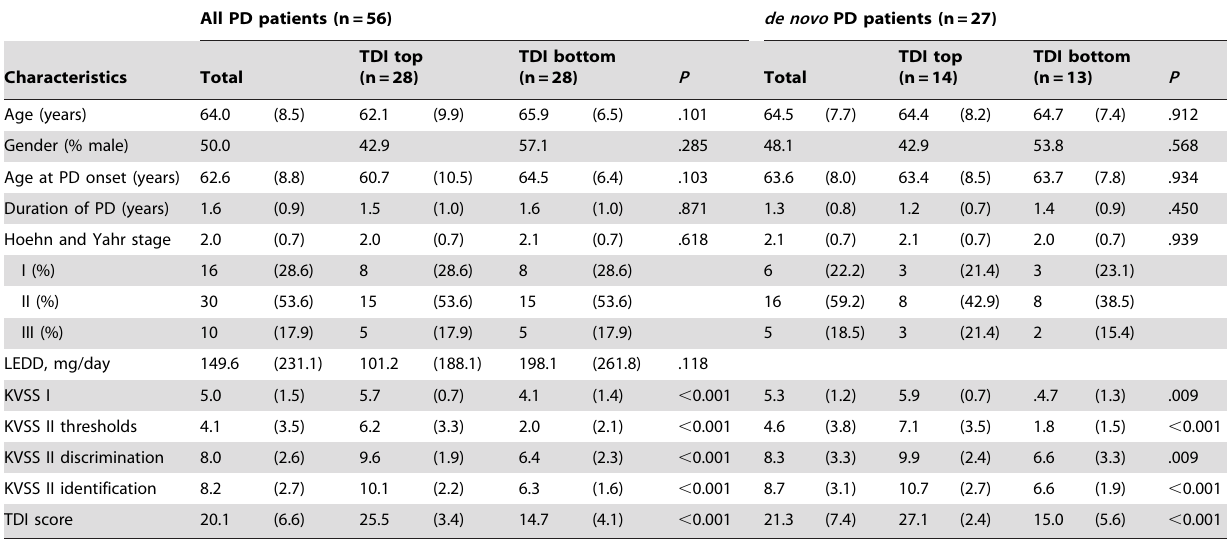
Table 1. Demographics and clinical profiles of the PD patients.